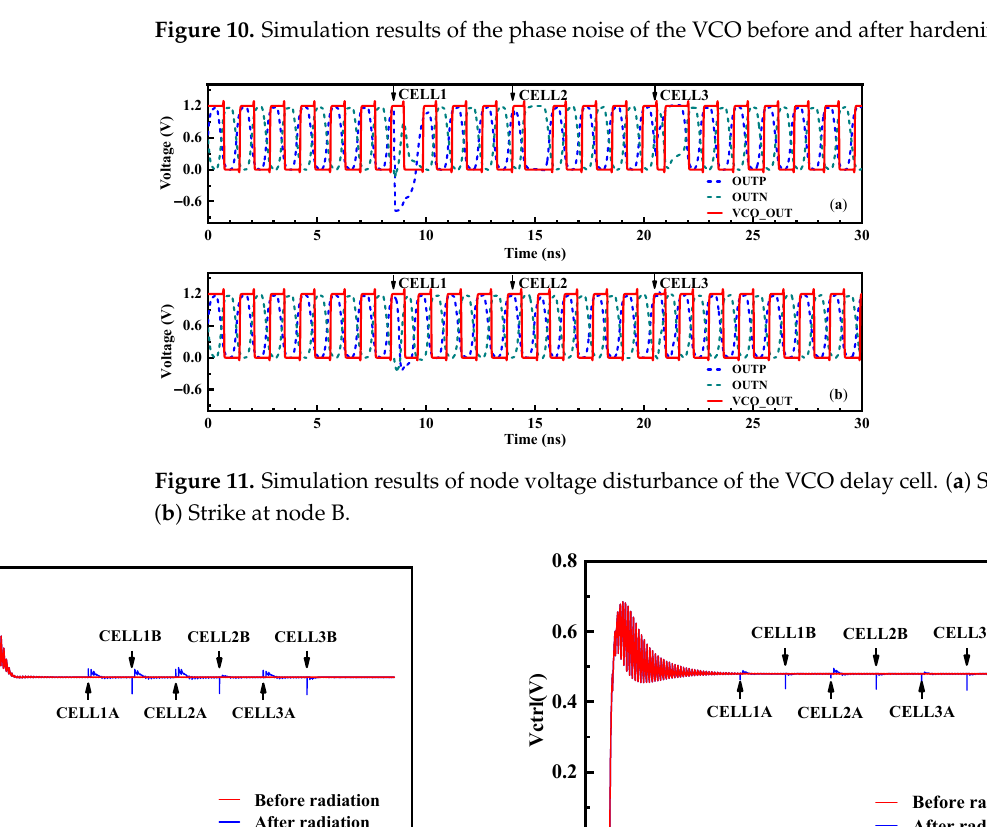
( b ) Figure 13. Performance comparison results of the three delay cells at different times in the same cycle before and after hardening. ( a ) Comparison result of the phase error. ( b ) Comparison result of the SET current pulses.